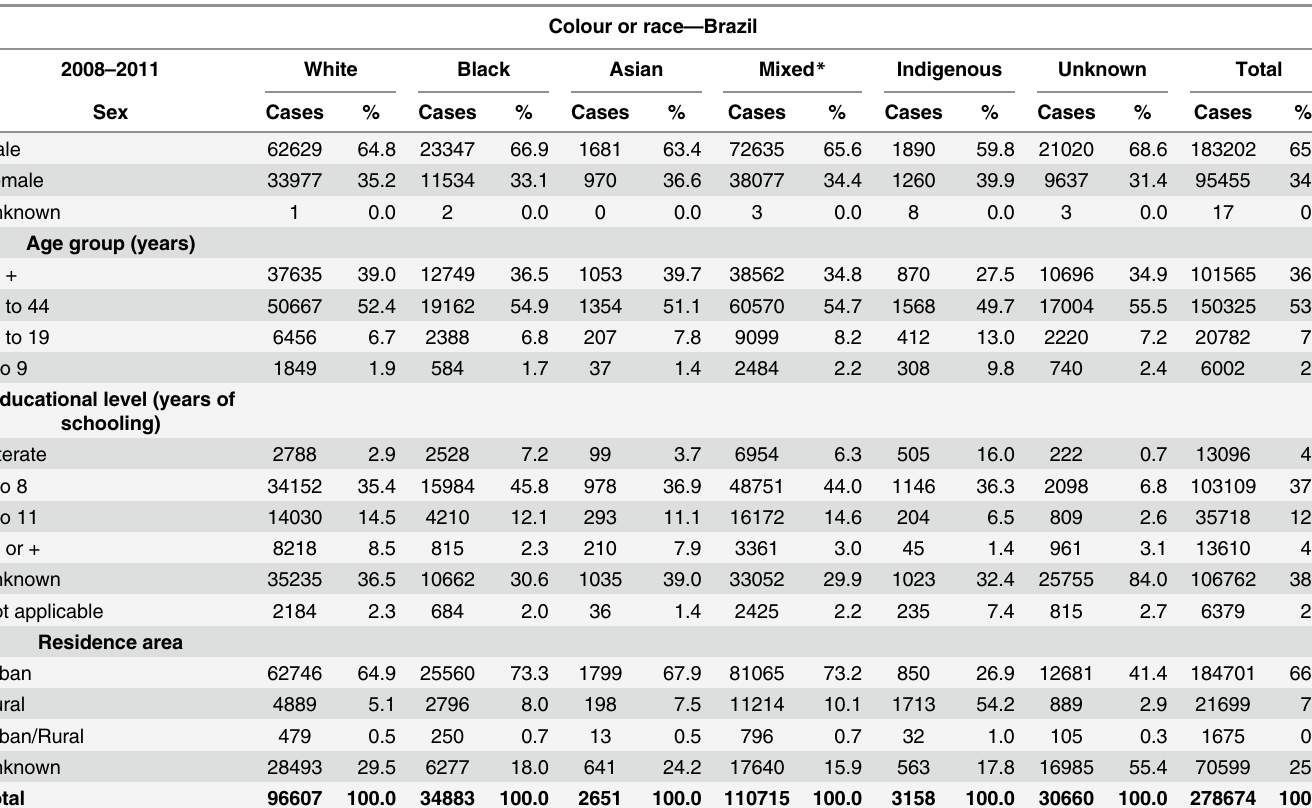
Table 2. Distribution of Notified New Cases of Tuberculosis in Brazil, by Sex, Age Group, Educational Level, and Residence Area, According to Colour or Race, Brazil, 2008 – 2011. Source: Sinan-TB/MS. Note: * In Brazil, the Mixed race category called Pardo, which means a mixture of European, Black and